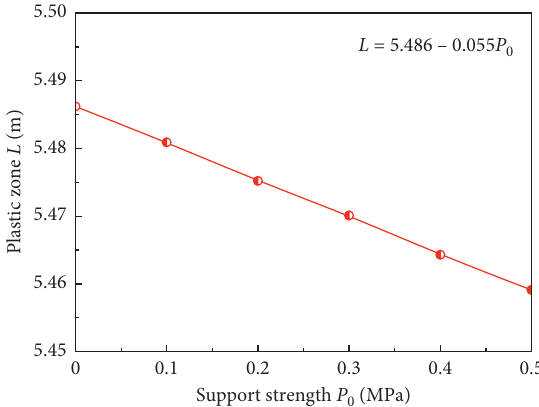
Figure 6: The plastic zone with different support intensity.